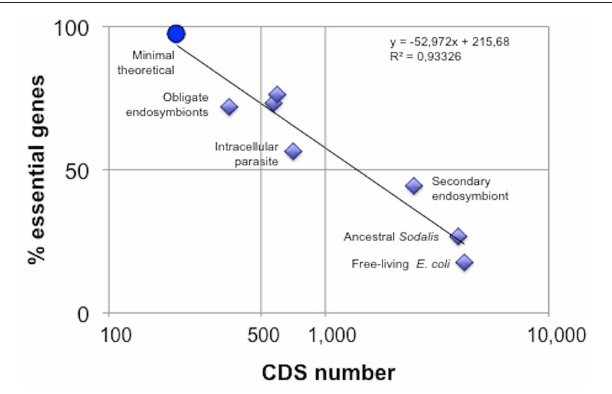
FIGURE 1 | Network fragility increases with metabolic minimization. Gene essentiality was determined in in silico knock-out experiments using Flux Balance Analysis (FBA) on metabolic models inferred from complete genomes, except for the minimal theoretical network, based on CMG (Gil et al., 2004), where Elementary Flux Mode analysis was used. From right to left, the data points correspond to E. coli (Belda et al., 2012), ancestral and extant S. glossinidius network (Belda et al., 2012), M. pneumoniae (Wodke et al., 2013), Blattabacterium (González-Domenech et al., 2012), B. aphidicola BAp (Thomas et al., 2009), B. aphidicola BCc (Belda et al., 2012), and the minimal theroretical metabolism (Gabaldón et al., 2007). CDS, protein coding